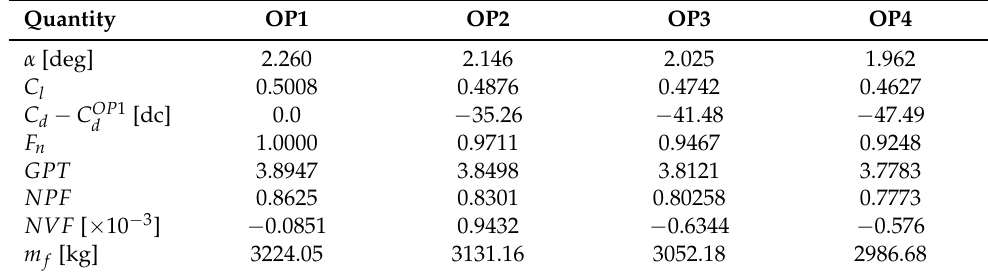
Table 2. Summary of evaluated mission points along the cruise segment. Thrust quantities are normalised by F n at OP1.